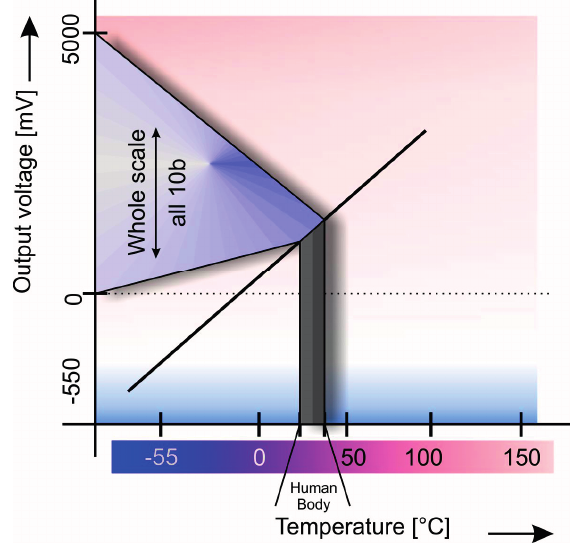
Figure 2. Small signal is magnified to full converter’s scale to achieve maximum A/D